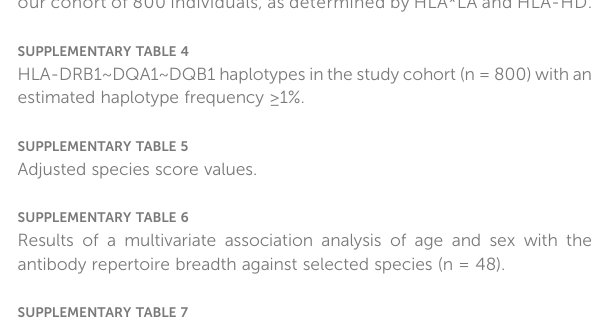
SUPPLEMENTARY TABLE 3 List of HLA class II alleles, including allele frequencies, number of homozygous individuals and number of heterozygous individuals in our cohort of 800 individuals, as determined by HLA*LA and HLA-HD.